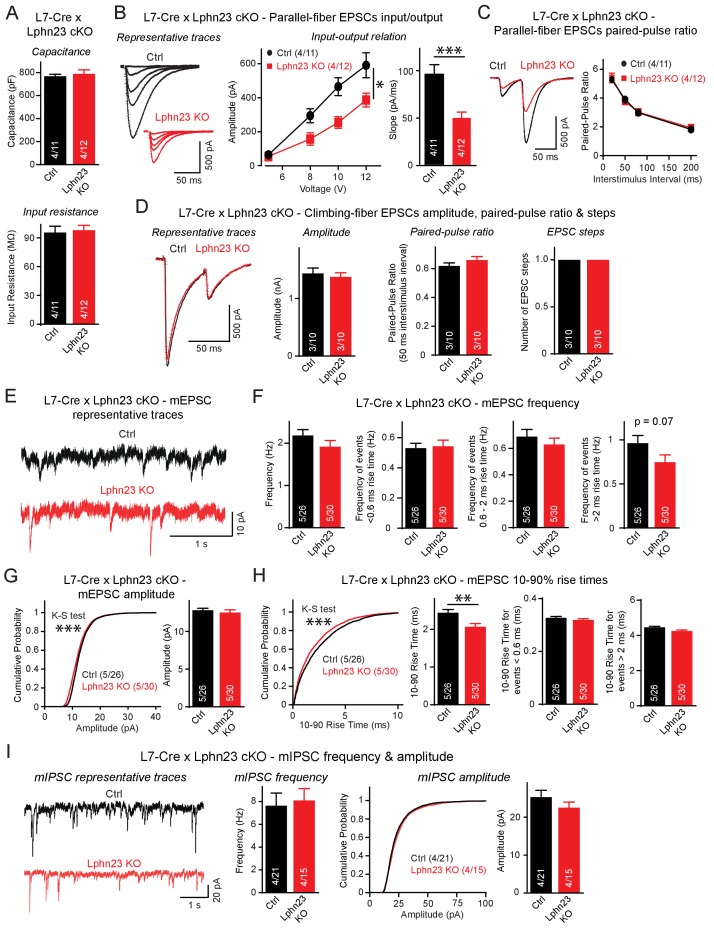
Double deletion of Lphn2 and Lphn3 from Purkinje cells suppresses parallel-fiber synaptic transmission without altering climbing-fiber synaptic transmission.(A) The Lphn2/3 double deletion from Purkinje cells does not affect their capacitance or input resistance. (B) The Lphn2/3 double deletion from Purkinje cells impairs parallel-fiber synaptic transmission as shown by diminished input-output relation and reduced slope of parallel-fiber excitatory postsynaptic currents (EPSCs) recorded from Purkinje cells (left, representative traces showing parallel-fiber EPSCs at increasing stimulus intensities; right, summary graph of input-output relation and parallel-fiber EPSC slope). (C) The Lphn2/3 double deletion from Purkinje cells has no effect of the paired-pulse ratio (PPR) of parallel-fiber EPSCs (left, representative traces of parallel-fiber-EPSCs of identical stimulus intensity with a 50 ms inter-stimulus interval; right, summary graph of PPRs with varying inter-stimulus intervals). (D) The Lphn2/3 double deletion from Purkinje cells does not affect climbing-fiber synaptic transmission or pruning with no differences observed in climbing-fiber EPSC amplitude, PPR or the number of steps in the evoked climbing-fiber response (left, representative traces of climbing-fiber EPSCs with a 50 ms inter-stimulus interval; right, summary graphs of climbing-fiber EPSC amplitude, PPR and number of steps). (E–F) The Lphn2/3 double deletion from Purkinje cells does not alter the frequency of spontaneous miniature excitatory postsynaptic currents (mEPSCs) but reduces the frequency of mEPSCs with rise times greater than 2 ms (E, representative traces of mEPSCs; F, summary graphs of mEPSC frequency of all events and events separated by 10–90% rise times). A majority of mEPSCs with 10–90% rise times under 0.6 ms are derived from climbing-fibers which synapse onto proximal Purkinje cell dendrites, while a majority mEPSCs with 10–90% rise times greater than 2 ms arise from parallel-fibers which synapse onto distal Purkinje cell dendrites. A trend nearing significance was observed for lower frequency of mEPSCs with 10–90% rise times greater than 2 ms in Lphn2/3 double KO cells compared to control (p=0.07). (G) The Lphn2/3 double deletion from Purkinje cells has minimal effects on mEPSC amplitude (left, cumulative frequency relation of mEPSC amplitudes; right, summary graph). A significant difference in the cumulative frequency relation of mEPSC amplitudes was observed between Lphn2/3 double KO and control by the Kolmogorov–Smirnov test but no significant difference in average mEPSC amplitude was identified by a two-tailed t test. (H) The Lphn2/3 double deletion from Purkinje cells reduces the 10–90% rise time of mEPSCs (left, cumulative frequency relation of rise times; right, summary graphs of all rise times, rise times less than 0.6 ms and rise times greater than 2 ms). Both the average and cumulative frequency relation of 10–90% rise times were significantly different between Lphn2/3 double KO and control, but no difference in average 10–90% rise times was detected in the subsets of mEPSCs with rise times under 0.6 ms or greater than 2 ms. (I) The Lphn2/3 double deletion from Purkinje cells does not affect amplitude or frequency of spontaneous miniature inhibitory post-synaptic currents (mIPSCs) recorded from Purkinje cells (left, representative traces of mIPSCs; middle, summary graph of mIPSC frequency; right, cumulative frequency plot and summary graph of mIPSC amplitudes). Data are means ± SEM; numbers in bars represent independent experiments/number of cells tested. *p<0.05, **p<0.01, ***p<0.001 (two-tailed t test and two-way ANOVA).